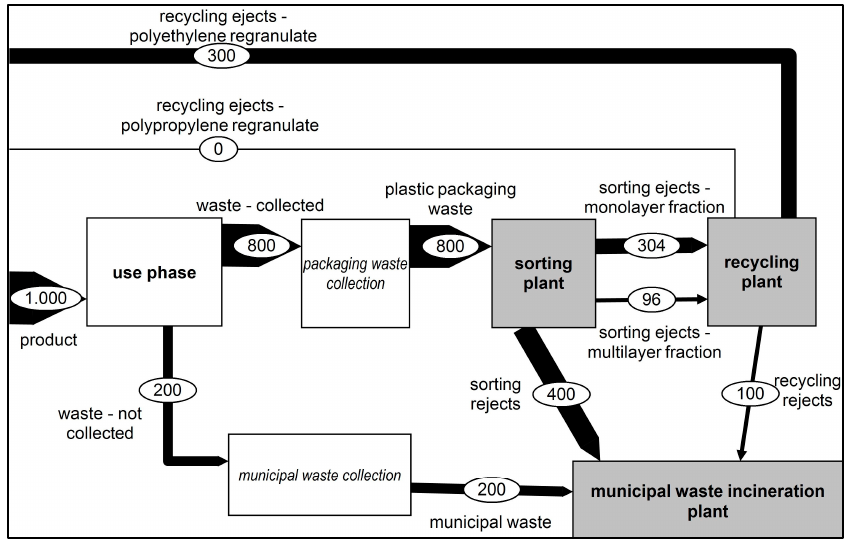
Figure 9. Representation of the material flows in Scenario 7.